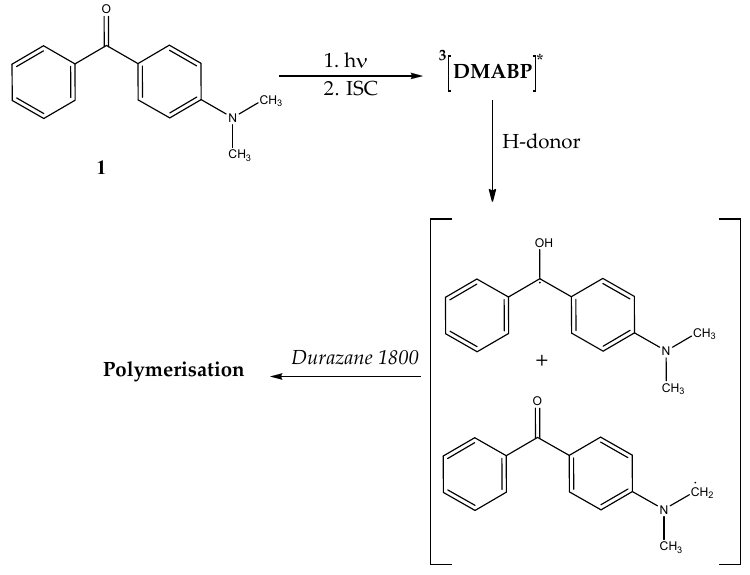
Figure 3. Schematic illustration of the initiation of DMABP upon UV light.